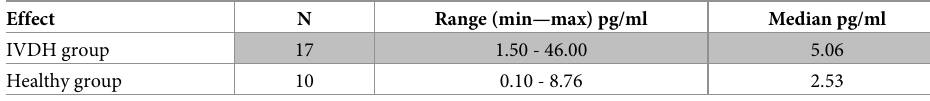
Table 4. IL-17 levels measured in CSF